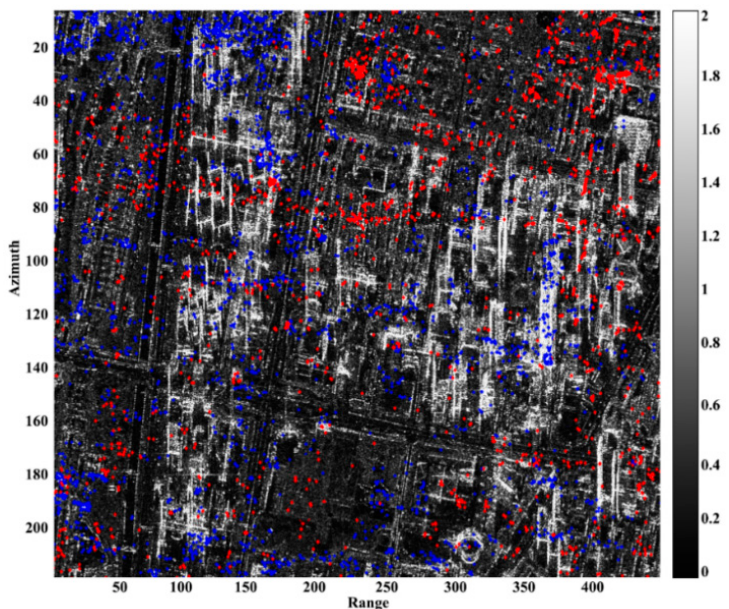
Figure 9. RELAX-derived single (red dots) and layover (blue dots) scatterers displayed over the experimental area B with highly dense urban setting (see Figure 1).